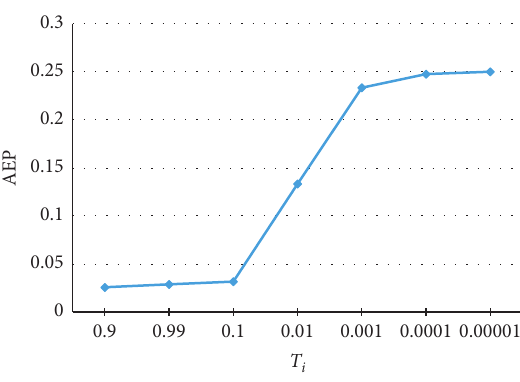
Figure 1: The AEP of different T